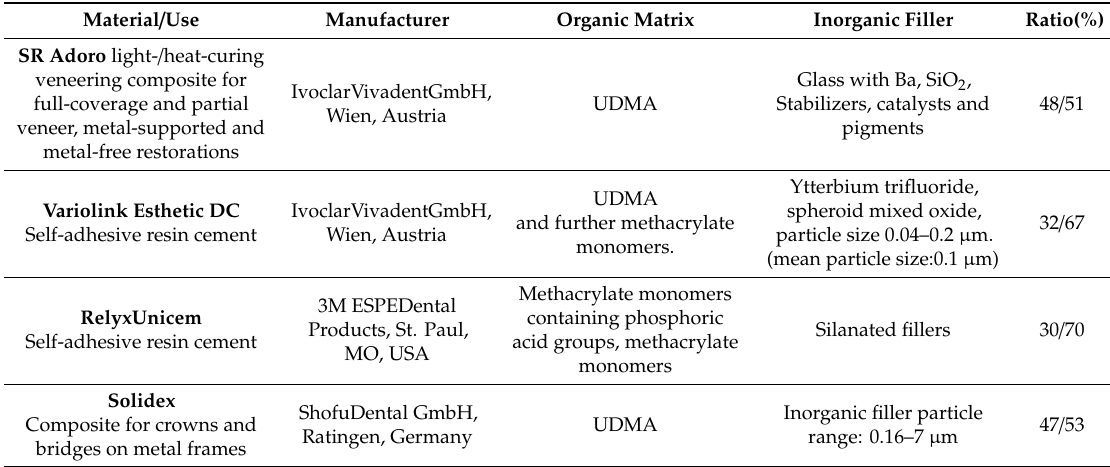
Table 1. Materials investigated in this